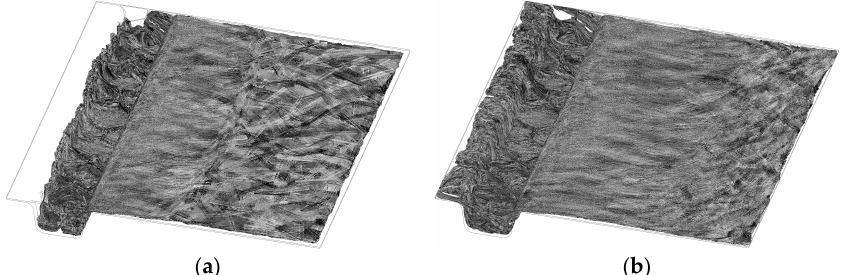
Figure 16. ( a ) Progressing flow front and deformed UD strands during the direct fiber simulation (DFS) with 3D TIMON CompositePRESS at an intermediate time step; ( b ) DFS result close to the end of compression.